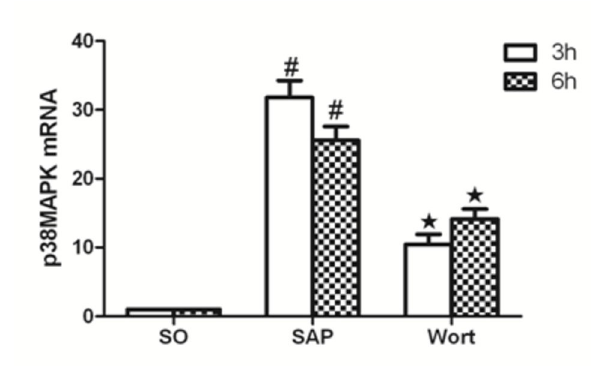
Figure 7. p38MAPK mRNA expression in each group at the 3 h and 6 h time point. # P <0.05 vs. SO group; ★ P <0.05 vs. SAP group.